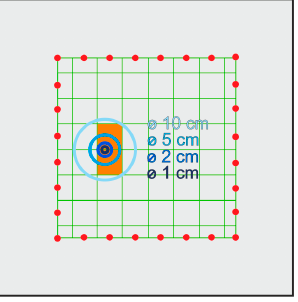
Figure 12. Location of damage with respect to the division of the element into pixels.